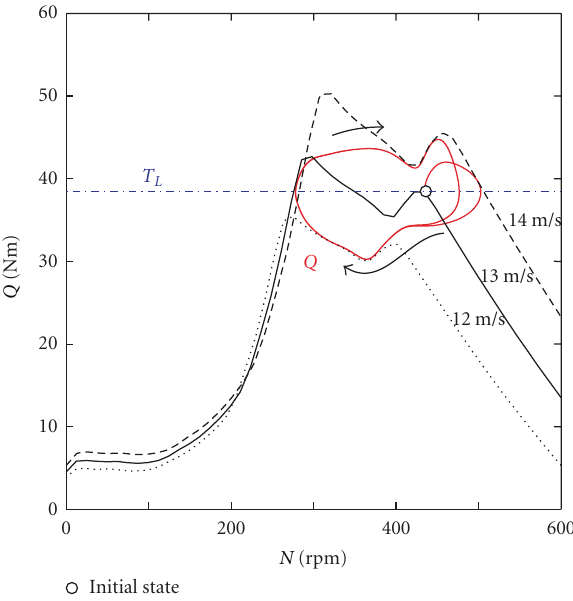
Figure 19: Locus of torque, Q , of pulsating wind in the case where V = 13 m/s, T = 32s, and I = 7kgm 2 . Constant load torque is T L = 0 38 . 3Nm. Final average rotational speed is N ave = 353 . 9 rpm.